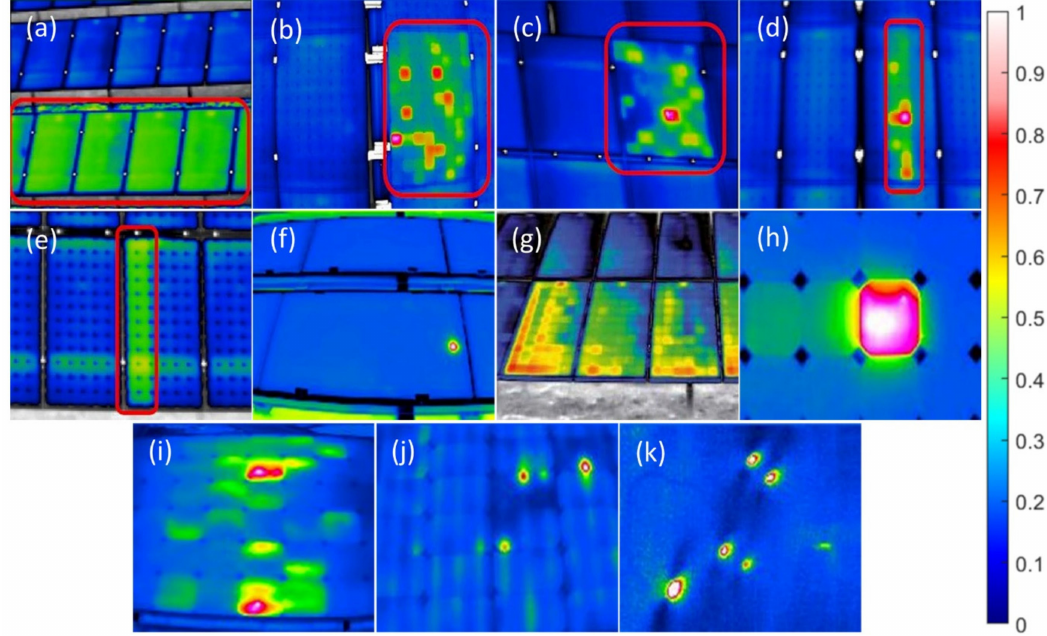
Figure 14. Summary of considered thermal patterns [33–36], which are described in Table